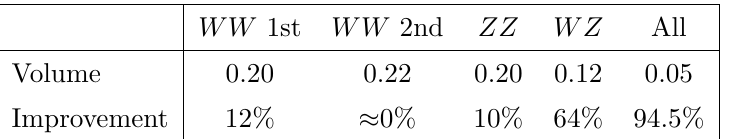
Table 2 . The volume of parameter space allowed by each quadratic and quartic positivity condition, together with the corresponding improvement when all other bounds are turned on. \All" is the combination of all quadratic and quartic